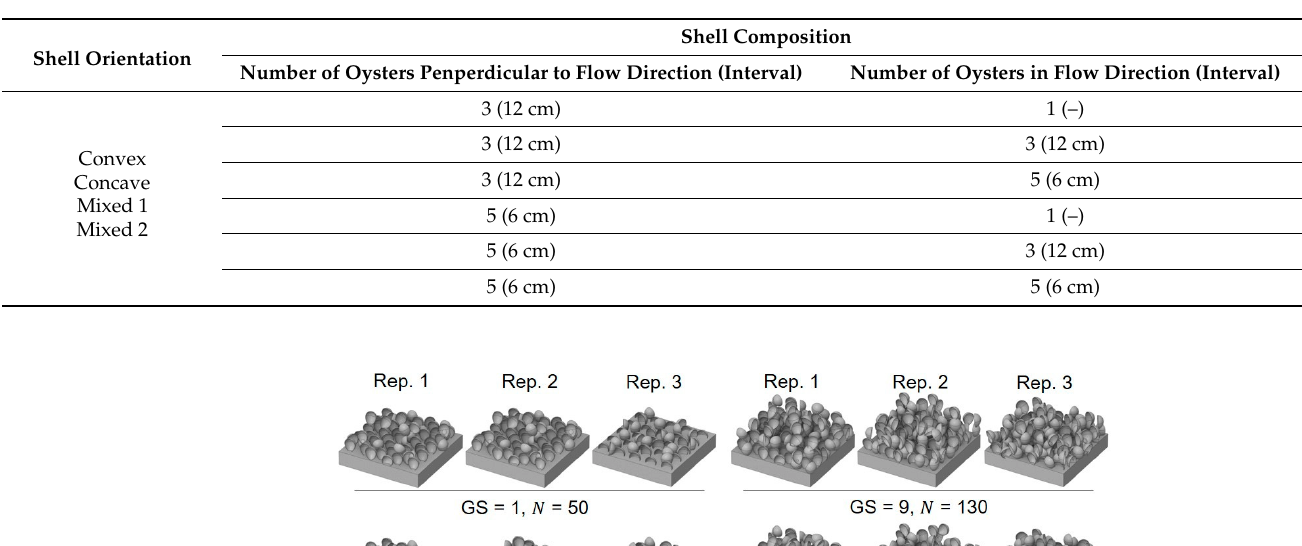
Table 1. The initial artificial oyster reef (AOR) model. A total of 48 initial AOR models were constructed by considering four shell orientations, six compositions, and two shell penetration depths.